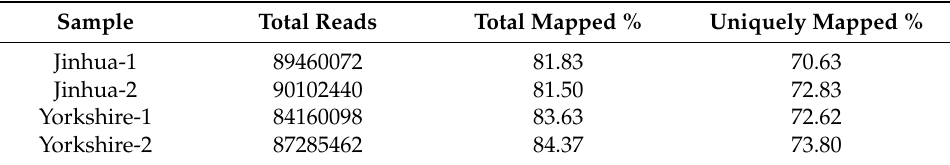
Table 2. Summary of the sequencing reads alignment to the reference